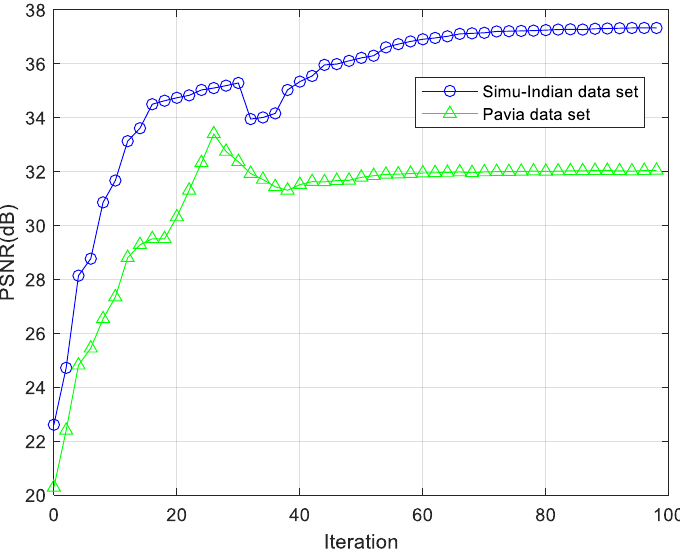
Figure 13. PSNR values with respect to the iterations for different datasets.